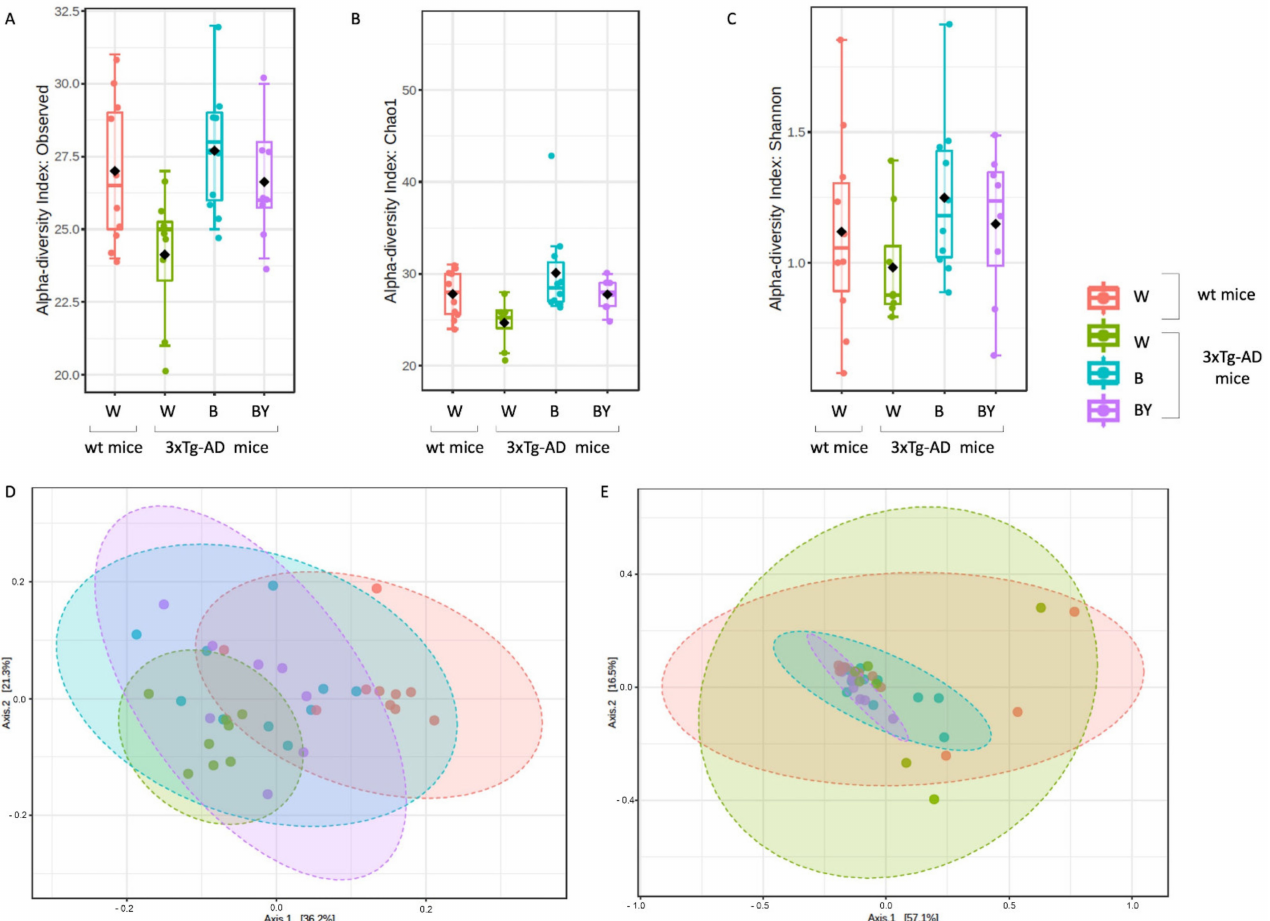
Figure 7. Alpha and beta diversity of the bacterial communities identified for each treatment in the wt (W) and 3xTg-AD mice (W, B and B/Y). Alpha diversity was measured using different metrics, observed species ( p = 0.02, ANOVA, panel A ), Chao 1 ( p = 0.02, ANOVA, B ) and Shannon index ( p = 0.36, ANOVA, C ), to evaluate the within-sample diversity and assess both the richness and evenness of each study group. Taken together, the plots show that the 3xTg-AD mice administered with water had a lower richness and evenness with respect to the wt mice, and that the treatments were able to positively affect the bacterial communities’ heterogeneity. Beta diversity was also evaluated to check between-group diversity. Unweighted (panel D ) and weighted (panel E ) Unifrac distances were measured. Statistical significance was measured by PERMANOVA test ( p < 0.001 and p < 0.21,